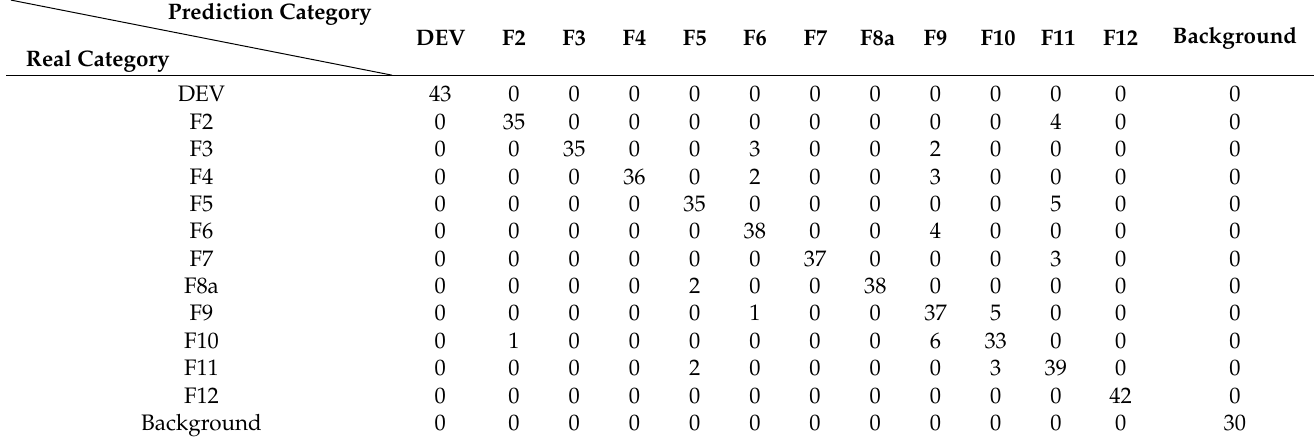
Table 3. Confusion matrix at optimal hyperparameter